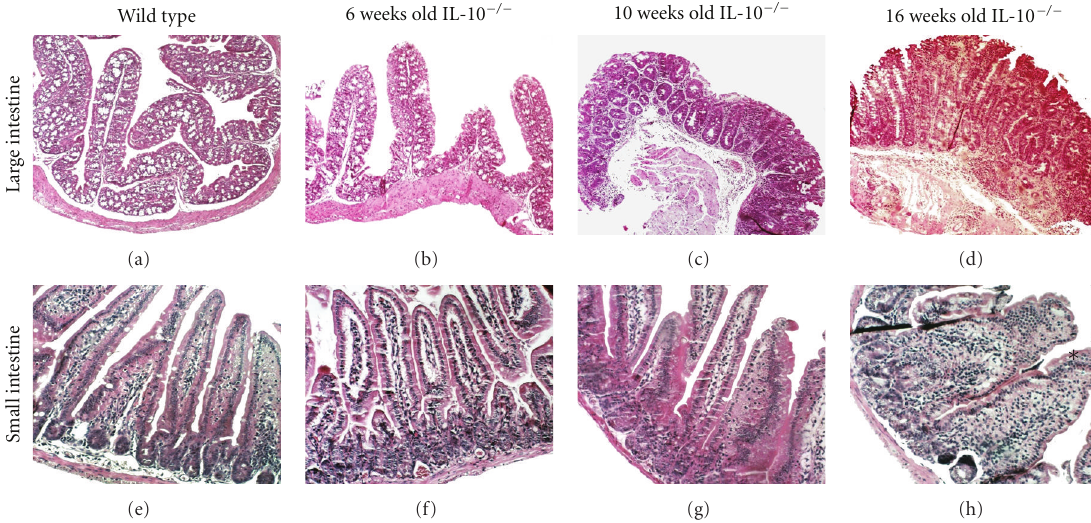
Figure 1: Histopathology of intestinal changes in IL-10 − / − mice. (a) Histology of proximal colon representative of wild-type (129Sv/Ev) mice (40x). No cellular infiltration between glands was found. (b) Proximal colon of 6-week-old IL-10 − / − mice (40x). Mucosa and submucosa are similar to the ones in wild-type mice. (c) Proximal colon of 10-week-old IL-10 − / − mice (40x). Multifocal infiltrations of leucocytes in the mucosa and submucosa. (d) Proximal colon of 16-week-old IL-10 − / − mice (40x). Presence of transmural inflammation a ff ecting the muscular layer can be observed. (e) Proximal jejunum representative of wild-type mice (100x). (f) Proximal jejunum of 6-week-old IL-10 − / − mice (100x). (g) Proximal jejunum of 10-week-old IL-10 − / − mice (100x). (h) Proximal jejunum of 16-week-old IL-10 − / − mice showing enteritis and cellular infiltration in the lamina propria (asterisks) (100x). Tissues were stained with hematoxylin and